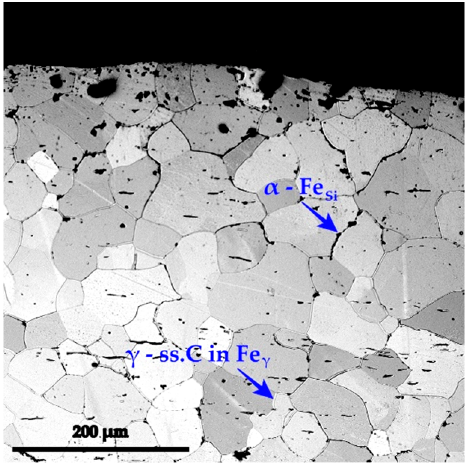
Figure 7. Microstructure detail revealing the magnitude and the effects of the diffusion coefficient on the grain size during silicon cementation; processing conditions: 950 °C/5 h; 40% FeSi75C; 9% NH 4 Cl; rest Al 2 O 3 ; etchant: Nital 3%. NH 4 Cl; rest Al 2 O 3 ; etchant: Nital